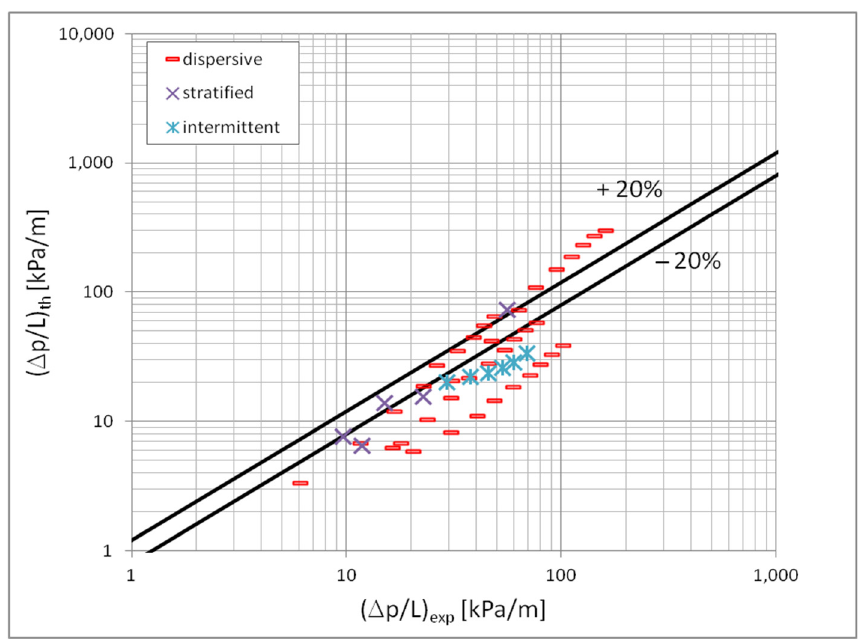
Figure 18. Comparison of the results of experimental research on pressure drop during condensa- tion of HFE7000 and HFE7100 refrigerants according to Mikielewicz et al. [10] in a mini-channel d h = 2.3 mm with calculations according to the correlation (3) in terms of dispersive, stratified and in- termittent flow.